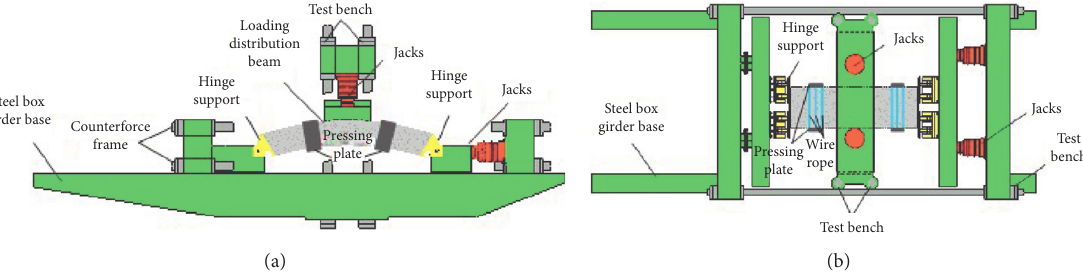
Figure 2: 3D schematic diagram of segment loading. (a) Front view of the structure; (b) top view of the